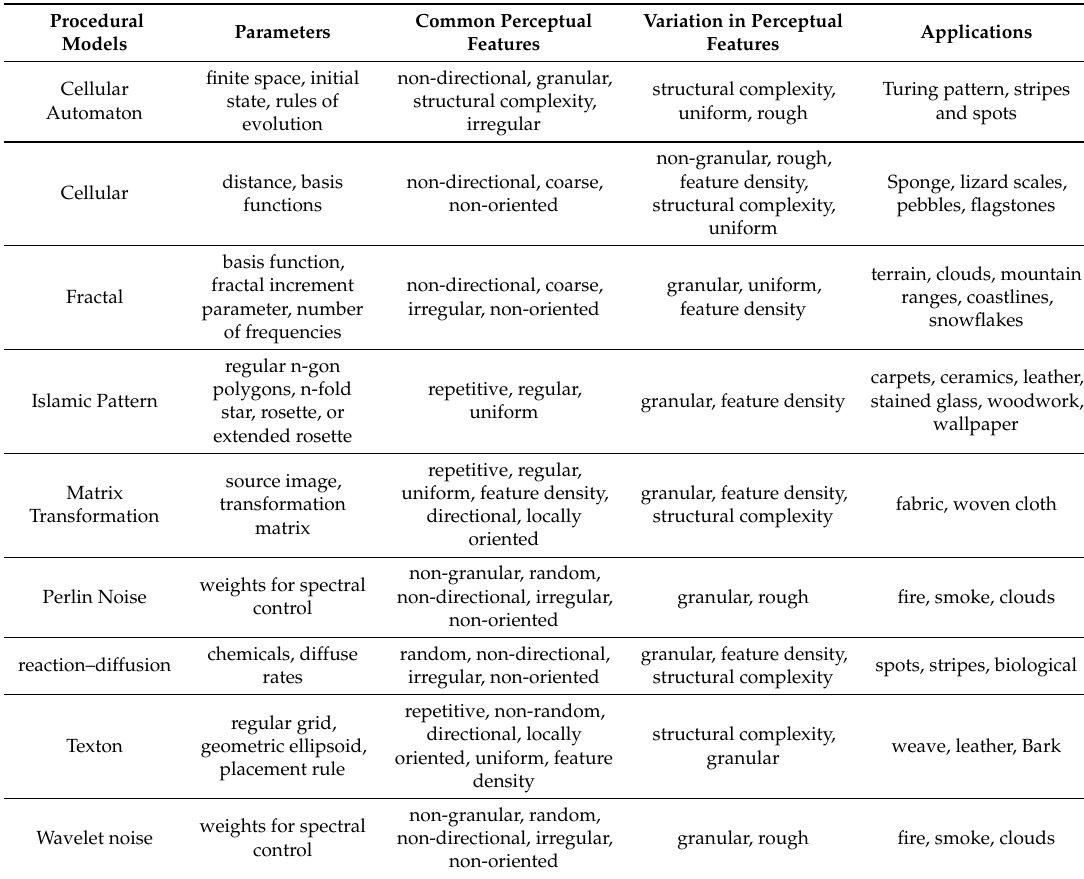
Table 1. Comparison of perceptual properties of procedural